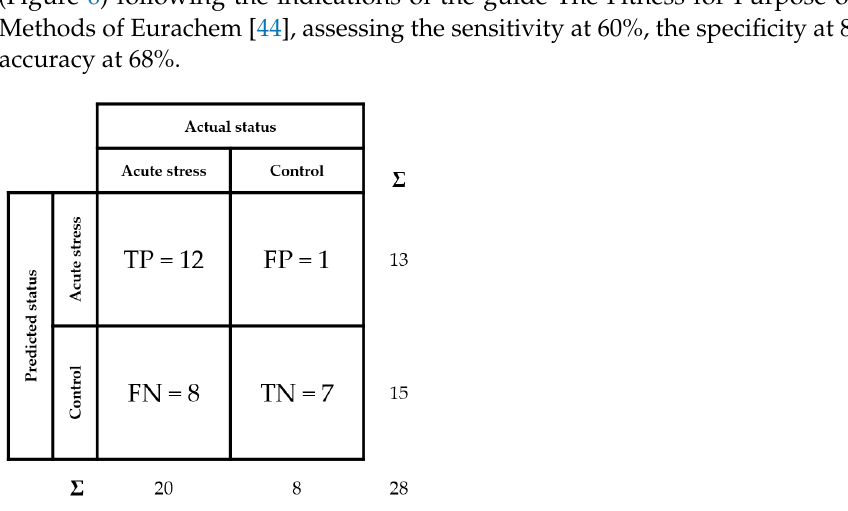
Figure 6. Confusion matrix of tear MMP-9 analysis over the different samples. True positive (TP), false positive (FP), false negative (FN), and true negative (TN) rates are detailed. Sensitivity is calculated as TP/(TP + FN), specificity as TN/(TN + FP), and accuracy as (TP + TN)/(TP + FP + FN + TN).